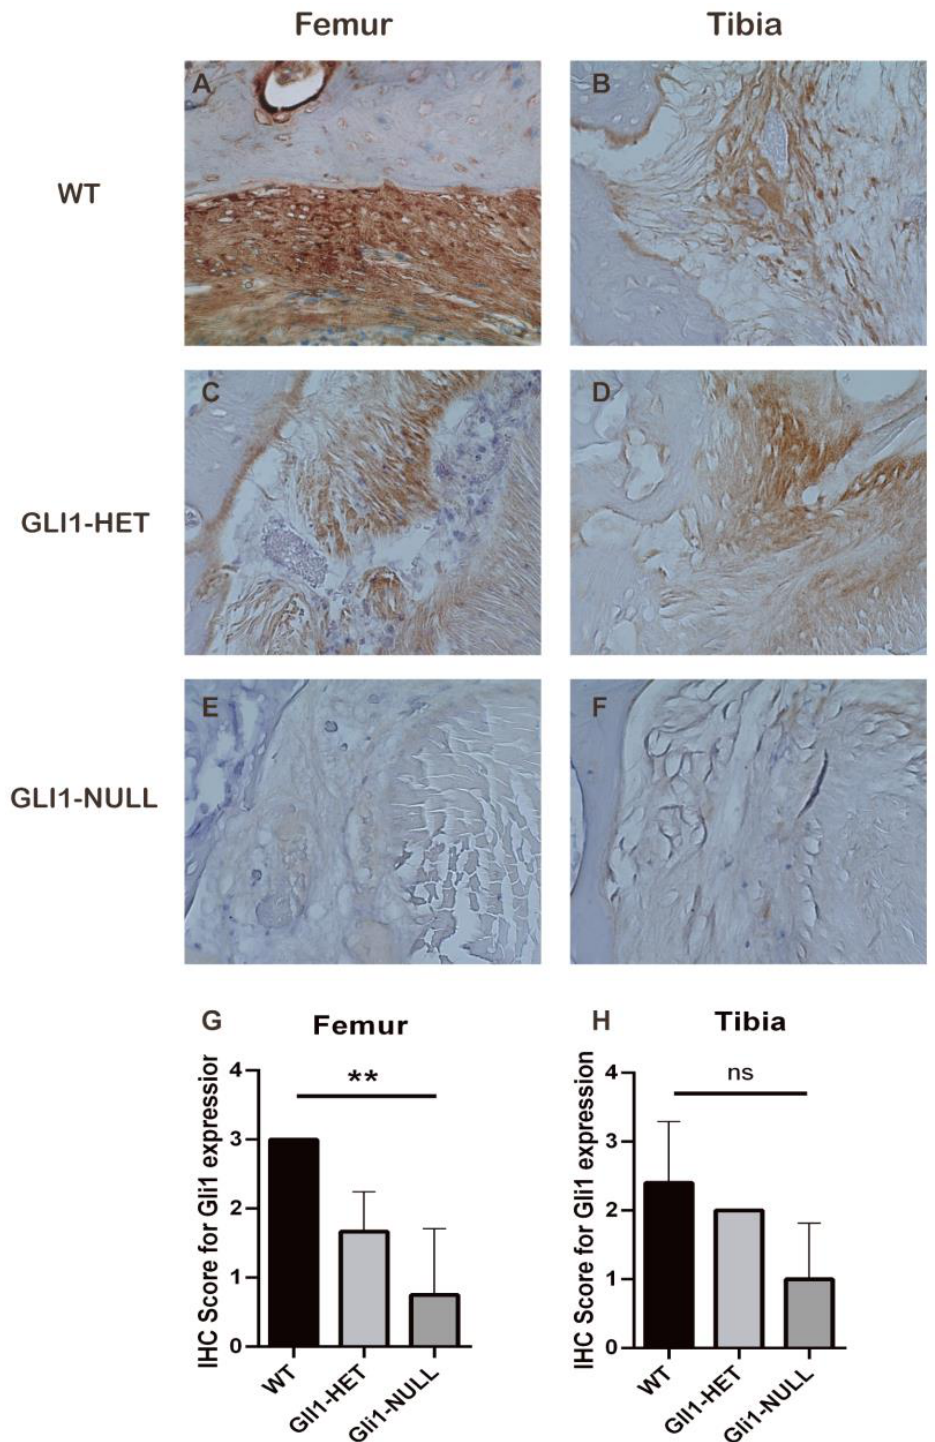
Figure 9. Representative images of GLI1 immunohistological staining of the tendon–bone interface of wild-type ( A , B ), GLI1-HET ( C , D ) and GLI1-NULL ( E , F ) mice at 4 weeks after ACLR (40 × ). GLI1 was positive at the interface only in the WT and GLI1-HET groups and was negative in the GLI1-NULL group. This difference was significant on the femoral side. ( G , H ) Values are presented as mean ± SD. **, p < 0.01.